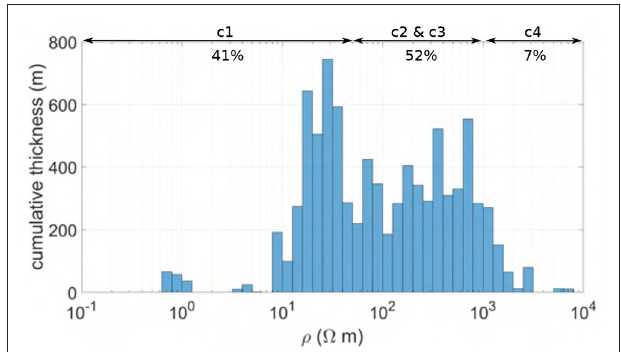
FIGURE 6 | Inverted resistivity histogram for the 89 TEM soundings performed along the whole area of study. The cumulative thickness is the sum of layer thickness corresponding to a specific resistivity range and the percentages correspond to the relative contribution of each class to the cumulative thickness